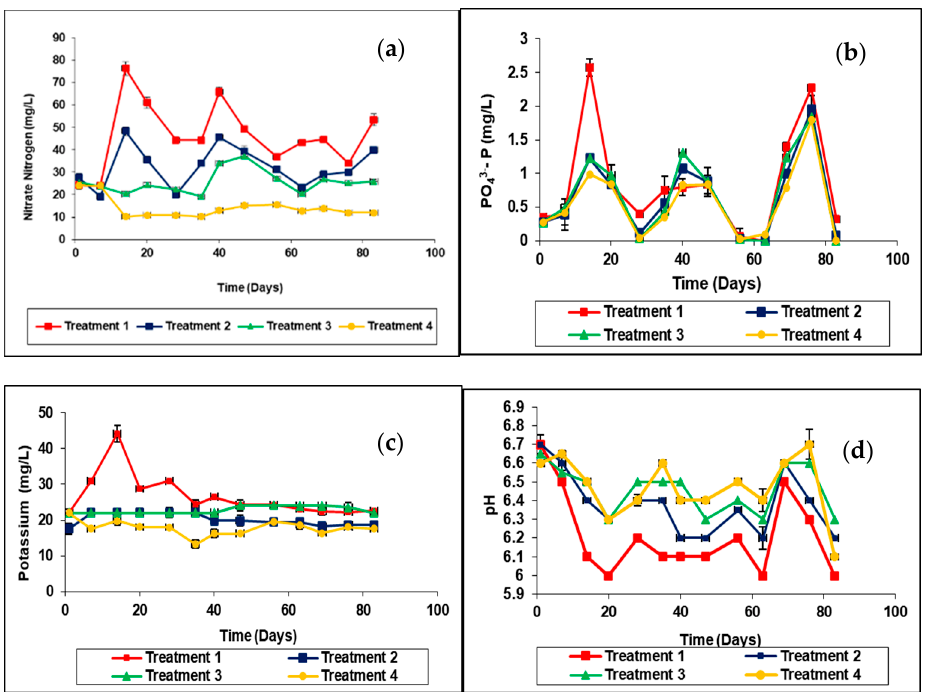
Figure 5. ( a ) Variation of NO 3 − -N with time; ( b ). Variation of PO 4 − 3 -P with time; ( c ). Variation of K+ with time; ( d ). Variation of pH with time in the leaching column